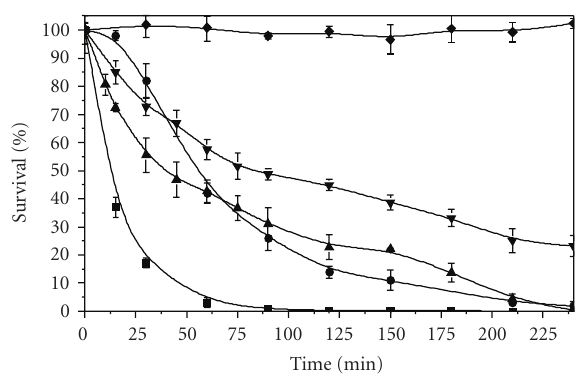
Figure 6: Comparison between photocatalytic and photolytic inactivation of E. coli in surface and distilled water (TiO 2 , UV, Distilled water) , (TiO 2 , UV, Surface water) • , (UV, Distilled (cid:0) , (UV, Surface water) , Dark control (with permission, water) (cid:2) (cid:3) (cid:4) from